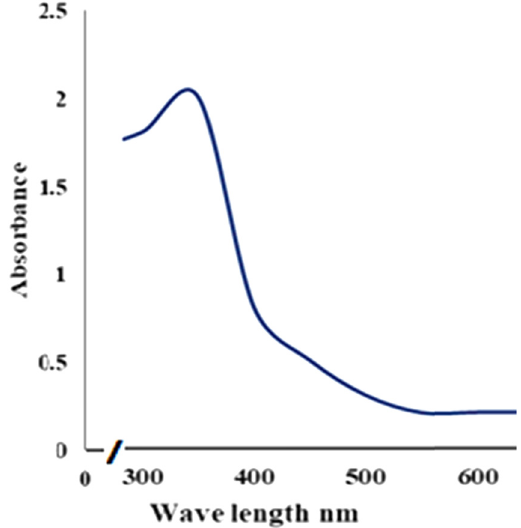
Figure 1: UV - vis spectra showing the absorbance peak of green - synthesized M. oleifera –